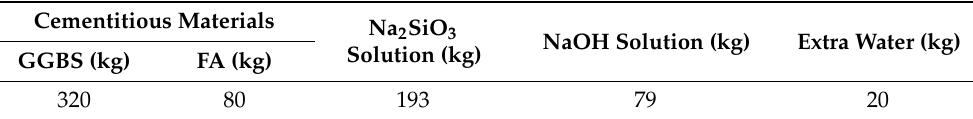
Figure 2. Production process of synthesized biomass recycled aggregate. Table 3. The cementitious material system of synthetic biomass recycled aggregate (per cubic meter of synthesized biomass recycled